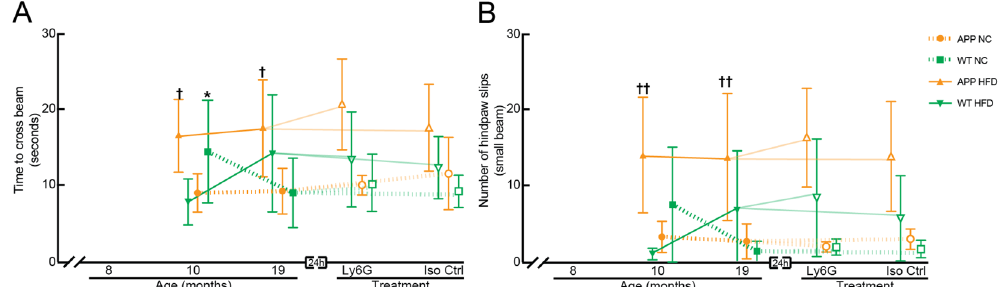
Figure 5. Behavioral assays for sensory-motor function in APP/PS1 and WT mice on a Hfd or normal chow as a function of age and after treatment with α -Ly6G or Iso-Ctr antibodies. Groupwise averages of balance beam performance measured by ( A ) the time to cross the beam and ( B ) the number of hindpaw slips while crossing for mice at 10 and 19 months of age, and taken 24 hrs after α -Ly6G or Iso-Ctr antibody administration at the 19 month time point (4 mg/kg animal weight, intraperitoneal). Animal numbers for all measurements — 10 months: APP/PS1-NC: n = 6; WT-NC: n = 9; APP/PS1-Hfd: n = 10; WT-Hfd: n = 11; 19-months: APP/PS1-NC α -Ly6G: n = 5; APP/PS1-NC Iso-Ctr n = 4; WT-NC α -Ly6G: n = 7; WT-NC Iso-Ctr: n = 6; APP/PS1-Hfd α -Ly6G: n = 5, APP/PS1-Hfd Iso-Ctr: n = 5; WT-Hfd α -Ly6G: n = 4; WT-Hfd Iso-Ctr: n = 5. * p < 0.05 between genotypes (APP/PS1 vs. WT); † p < 0.05, †† p < 0.01 between diets (Hfd vs. NC); one-way ANOVA with post-hoc pair-wise comparisons using Dunn’s multiple comparison test; mixed-model to determine synergistic effect of genotype and diet – (time to cross: p = 0.06; number of hindpaw slips: p =